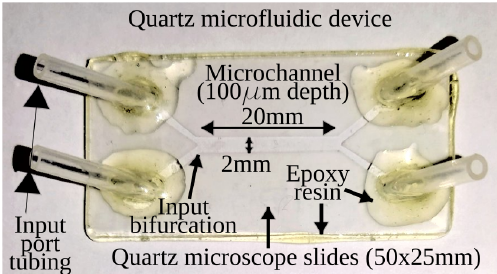
Figure 1. Microfluidic device.